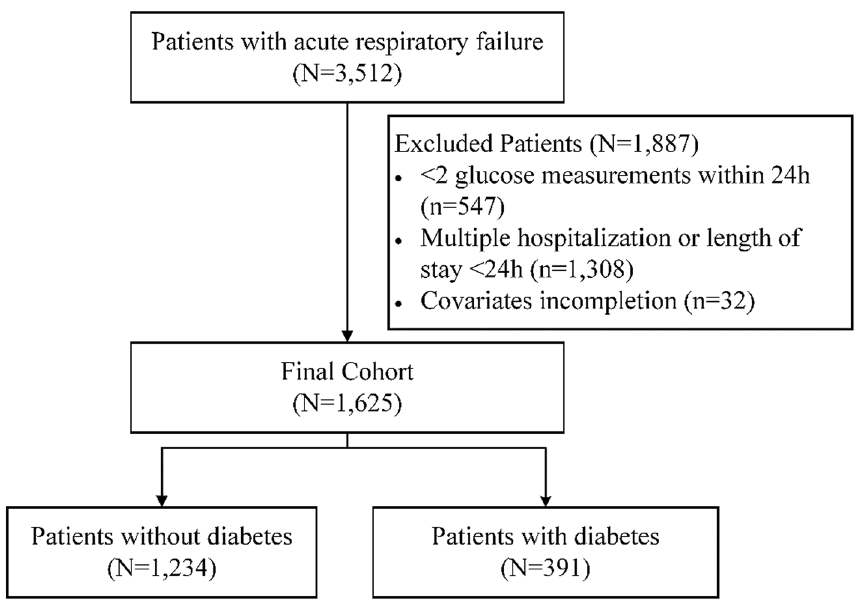
Figure 1. Flow chart of participant selection. A total of 1,625 patients were included in the